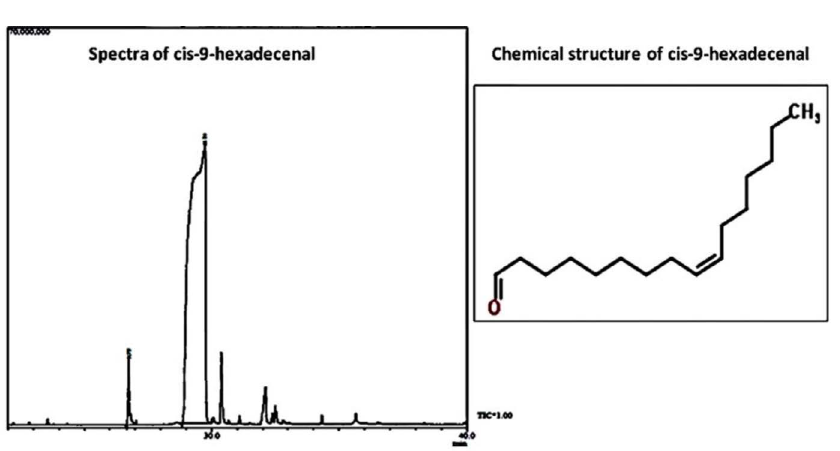
Fig. 2. GCMS chromatogram and chemical structure of the natural compound cis-9-hexadecenal.